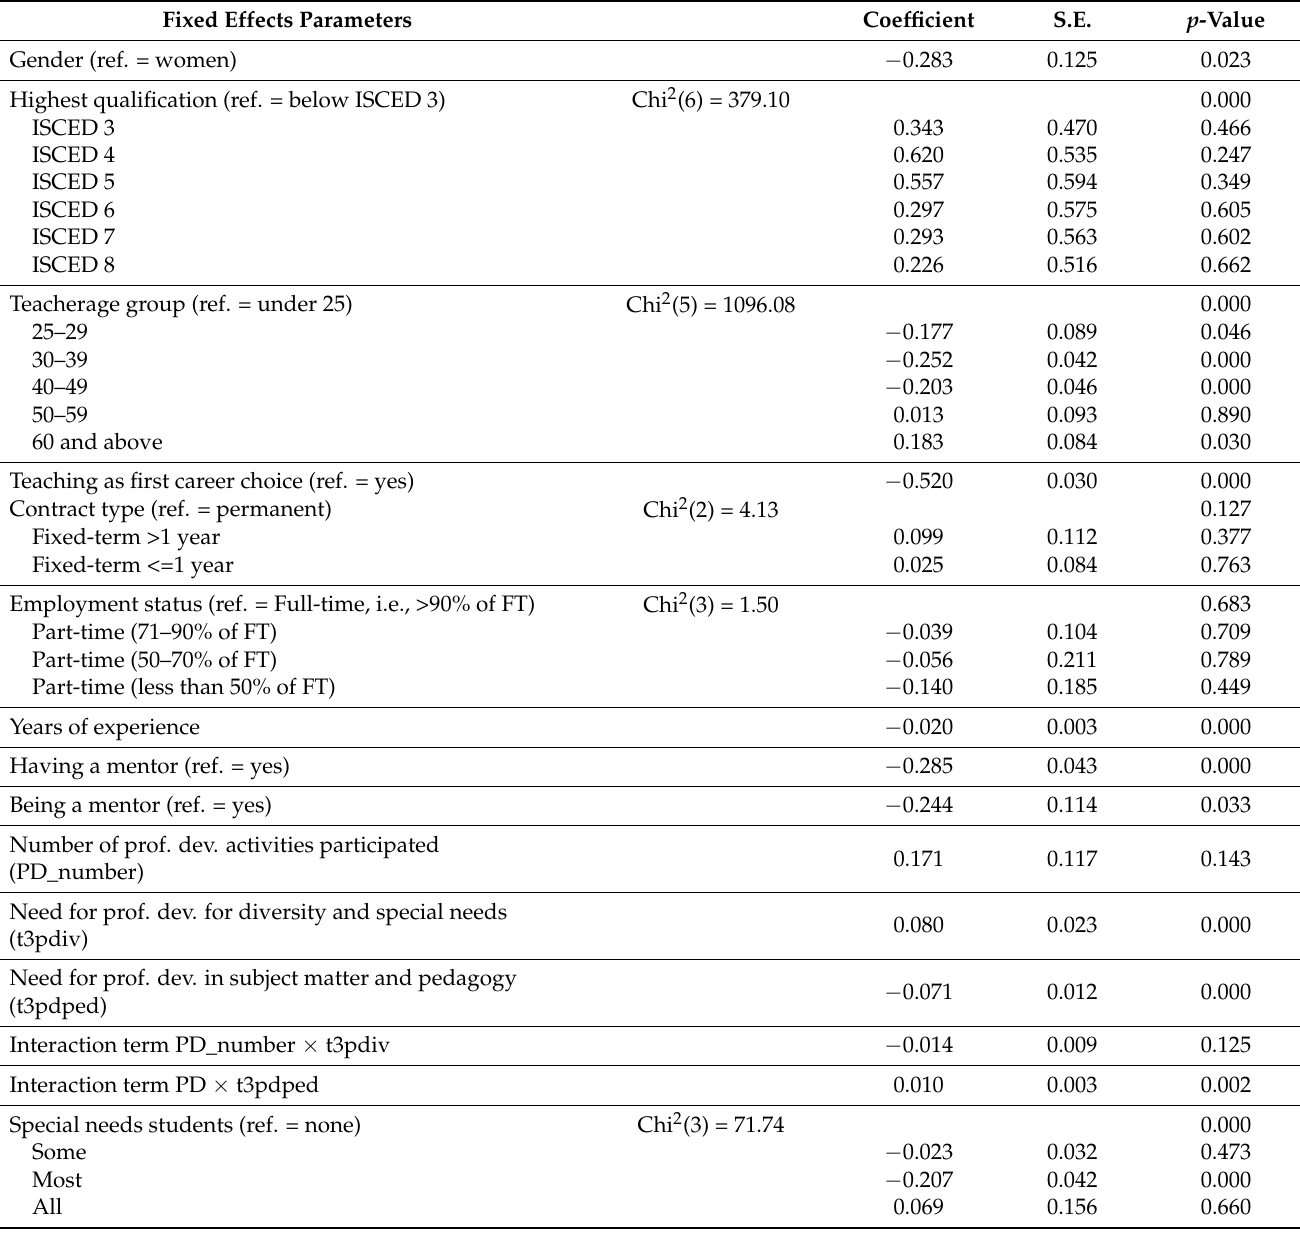
Table 3. Estimation results from multilevel